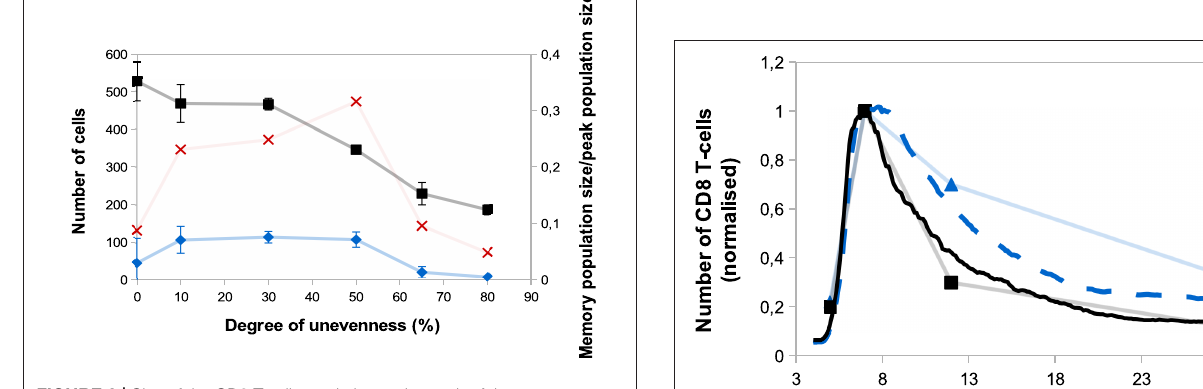
FIGURE 6 | Size of the CD8 T-cell population at the peak of the response (black squares, left axis) and size of the memory CD8 T-cell population at the end of the response D25 p.i. (blue diamonds, left axis) as functions of the degree unevenness of molecular partitioning (mean ± standard deviation over 5 simulations). Red crosses (right axis) show memory cell generation efficiency, measured as the ratio between the size of the memory CD8 T-cell population D25 p.i. and the size of the CD8 T-cell population at the peak of the response (mean over 5 simulations).